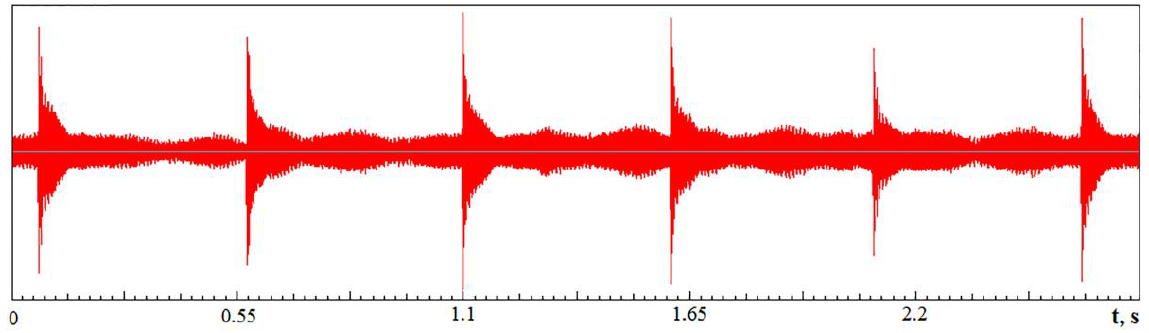
Figure 14. Recording of AE signals when a steel workpiece is exposed to a series of laser pulses.